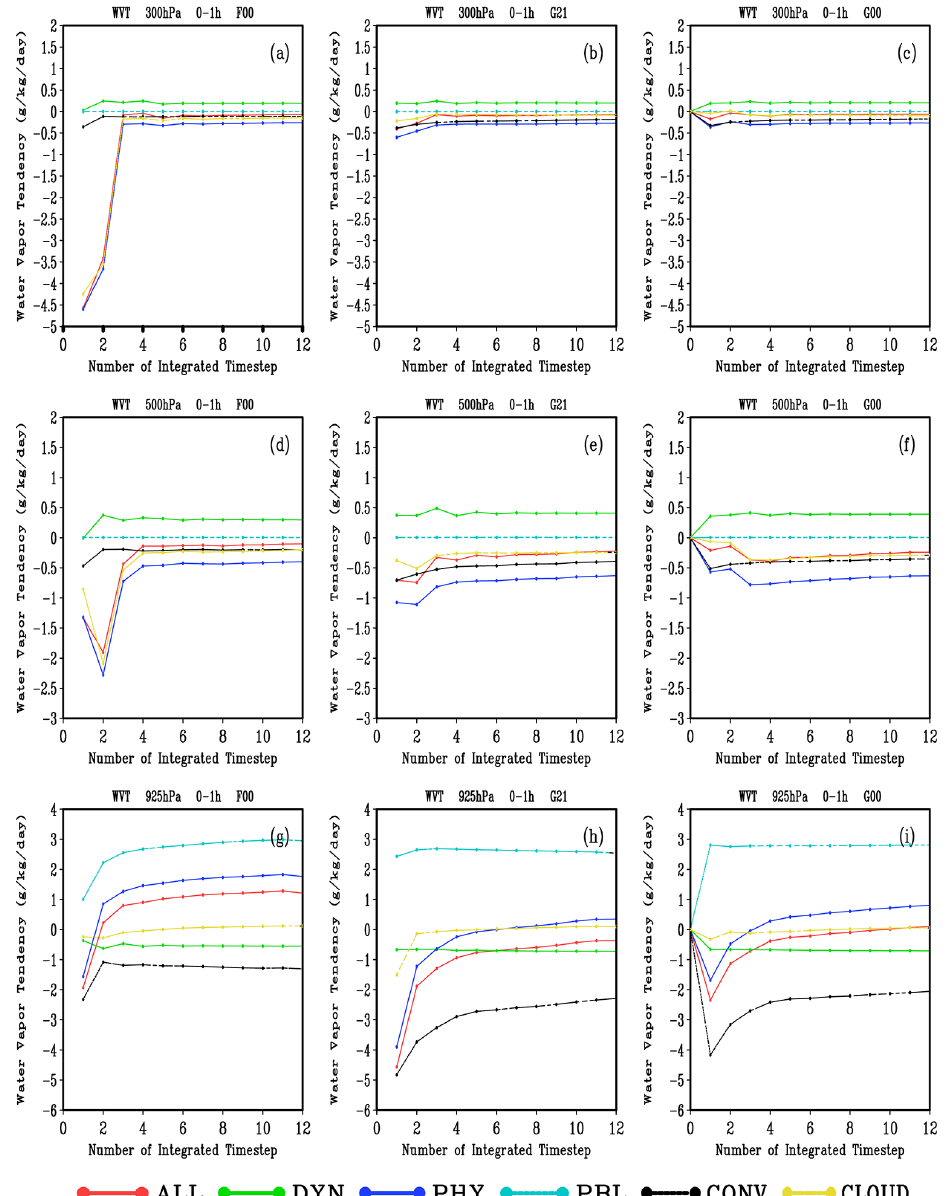
Figure 2. Time evolution of mean water vapor tendency (WVT) of the dynamical core and each physical process at 300, 500, and 925hPa heights from 0 to 1h simulated by the F00 (a, d, g) , G21 (b, e, h) , and G00 (c, f, i) experiments (values given in gkg − 1 d − 1 ).